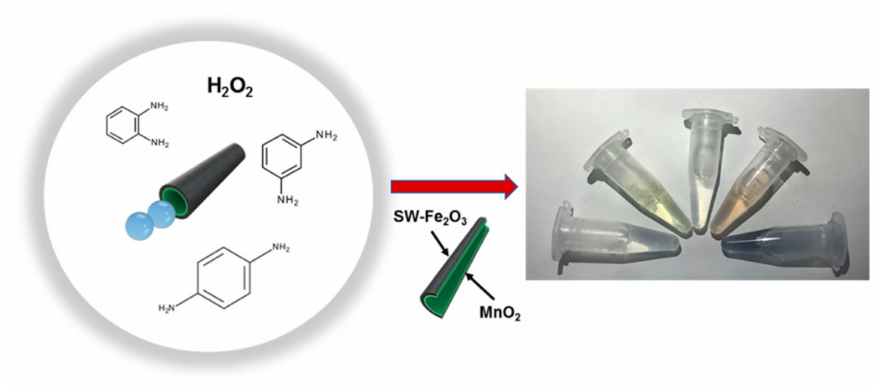
Figure 23. Schematic of the colorimetric assay with SW-Fe 2 O 3 /MnO 2 micromotors for phenylene- diamines detection. Reprinted with permission from ref. [79]. Copyright © 2018 American Chemi- cal